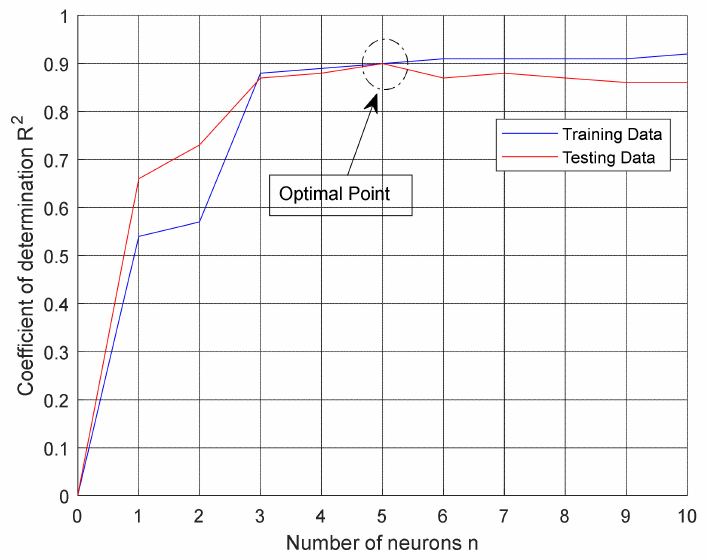
Figure 11. The coefficient of determination over the number of neurons with the testing data and training